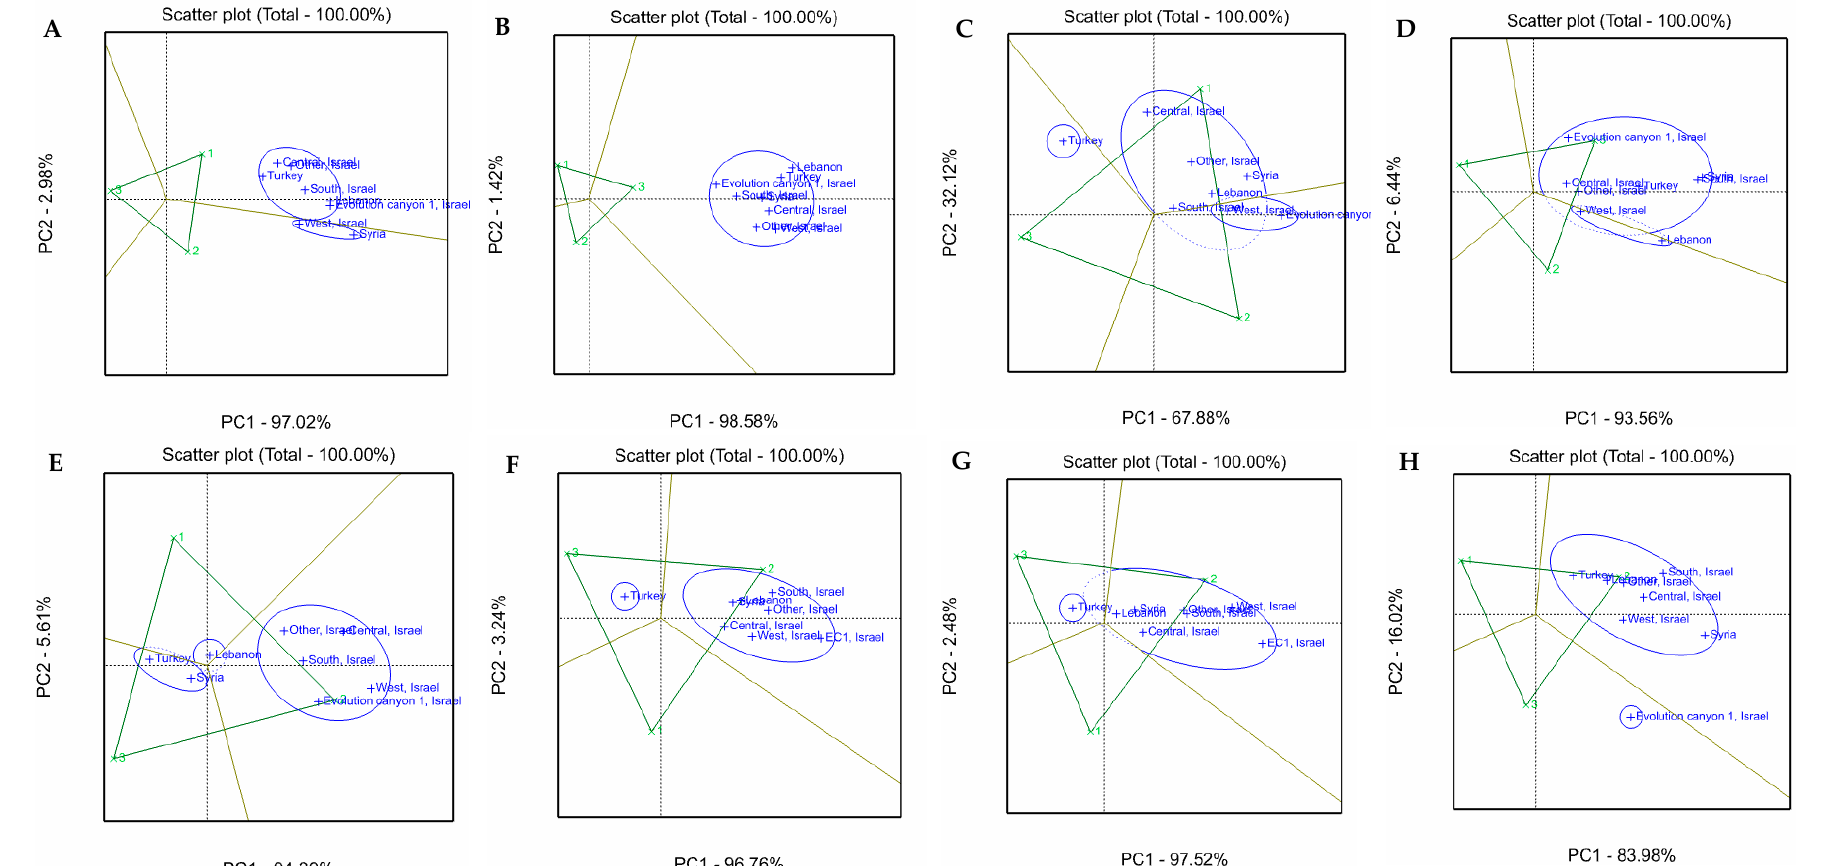
Figure 6. GGE biplot analysis for the population effect of wild emmer accessions in three environments using Flowering time ( A ), Plant height ( B ), Spike length ( C ), Shoot angle ( D ), Flag leaf area ( E ), Yield/plant ( F ), Thousand kernel weight ( G ), and Threshability ( H ) performance. Green points indicate environment (1, 2, and 3 for E1, E2, and E3, respectively); blue color represents populations: Central, South, West, EC1, and Non-specified (mentioned as Other) of Israel; Turkey, Lebanon, and Syria.